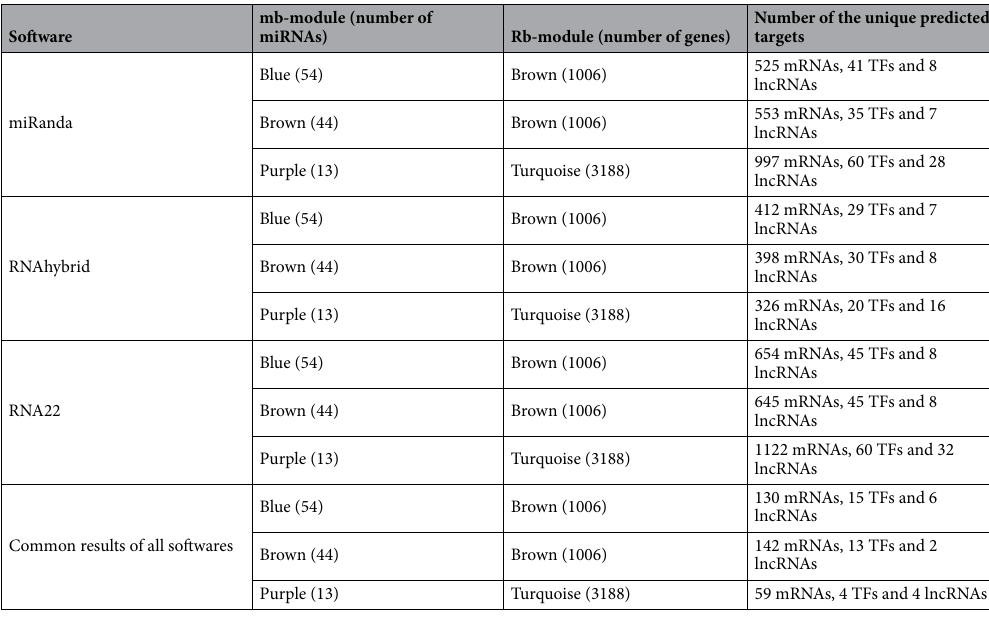
Table 2. The summary of the target prediction results for the mb-modules that were negatively correlated with mb-modules.